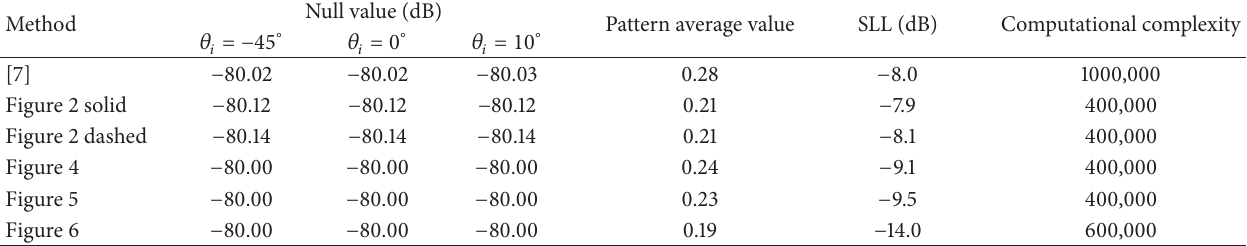
Table 1: Normalized pattern average value, normalised pattern null values, and SLL for different solutions. Method